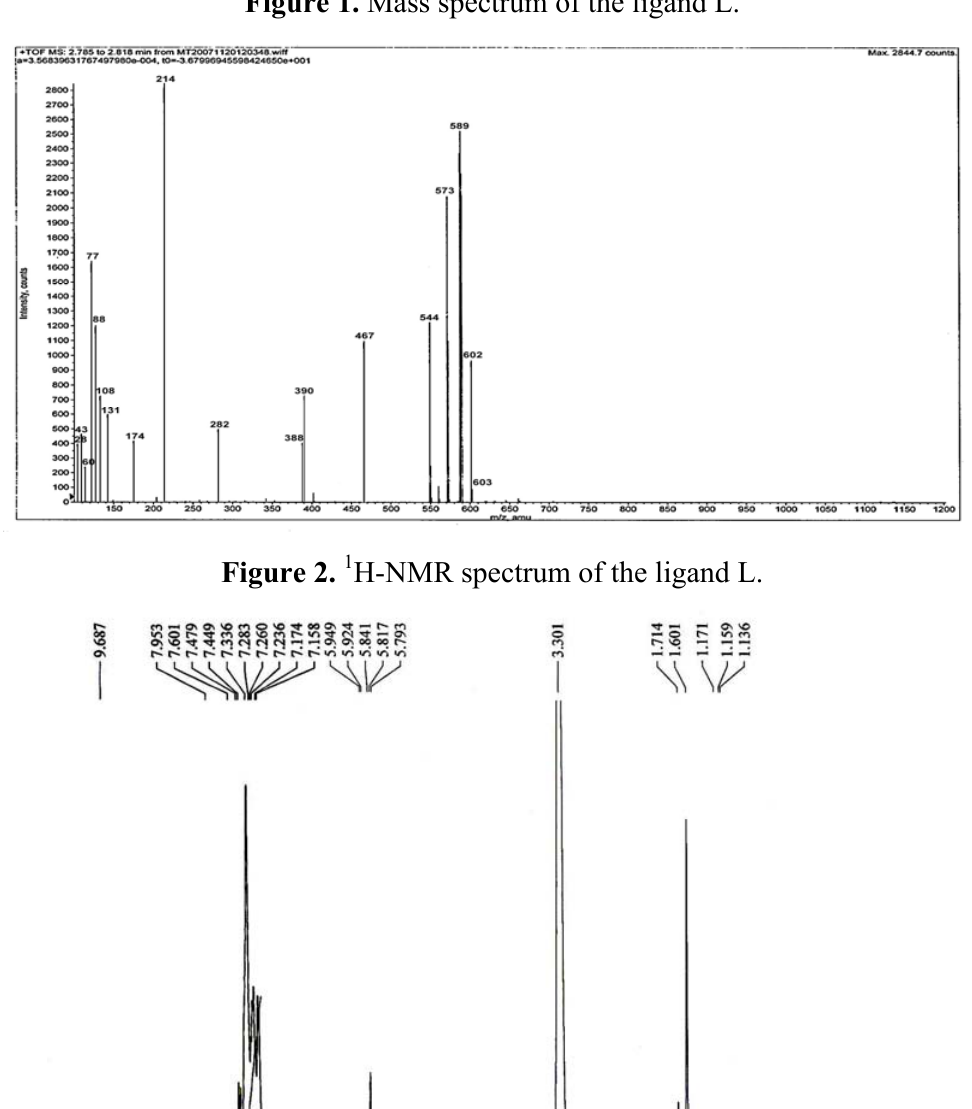
Figure 1. Mass spectrum of the ligand L.